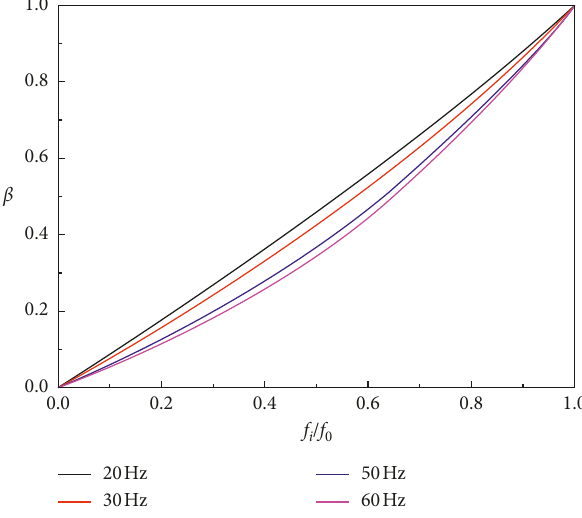
Figure 16: The curve of β with f